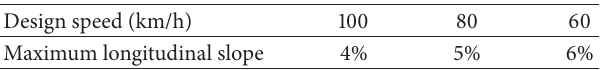
Table 9: Longitudinal slope standard for design speed.